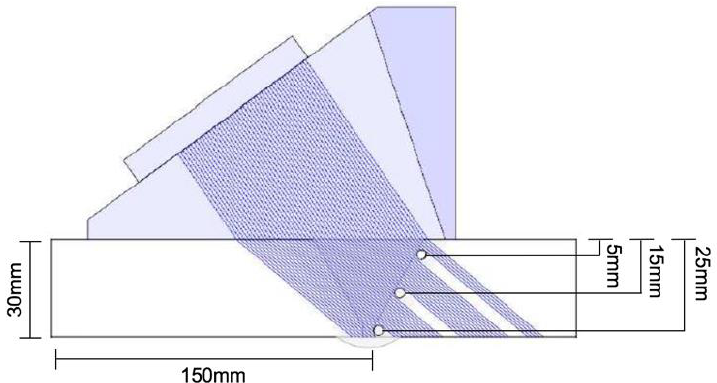
Figure 12. Simulation of sensitivity calibration with longitudinal waves in the calibration block, withdrawn from the 9% Ni quenched and tempered steel pipe joint welded with GTAW and SMAW processes using Ni-based superalloy 625 as the filler metal.